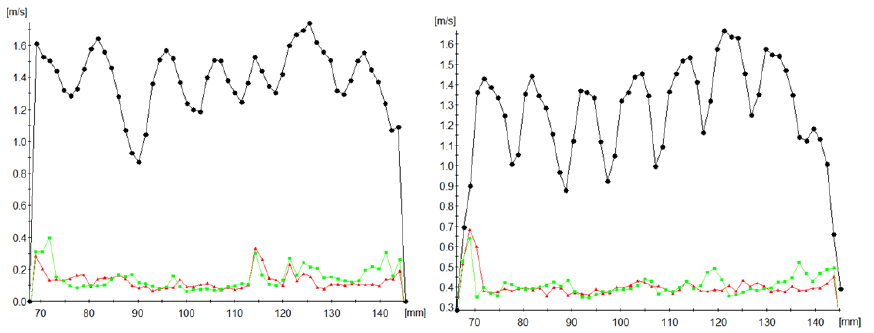
Figure 7 . The magnitude of velocity vector v (black) and their respective uncertainties U (red) and V (green) are 10 mm below the grounded wire mesh electrode ( left ) and 10 mm above the grounded wire mesh electrode ( right ).